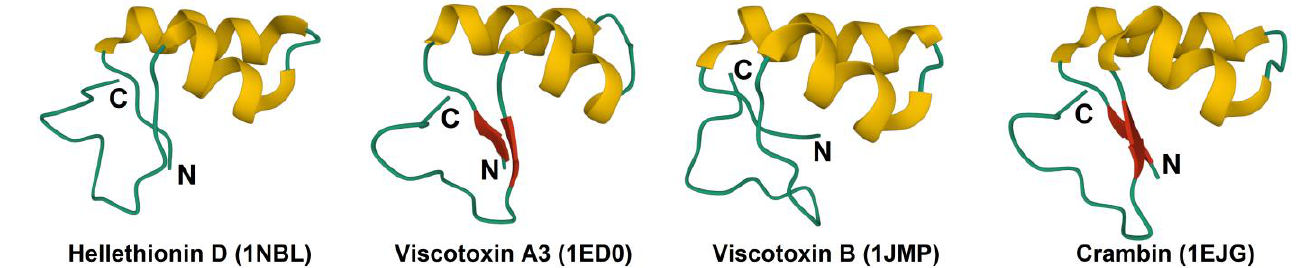
Figure 2. 3D structure of plant thionins. The α -helices are colored yellow, and the β -structures are colored red. The N- and C-termini are indicated by N and C,